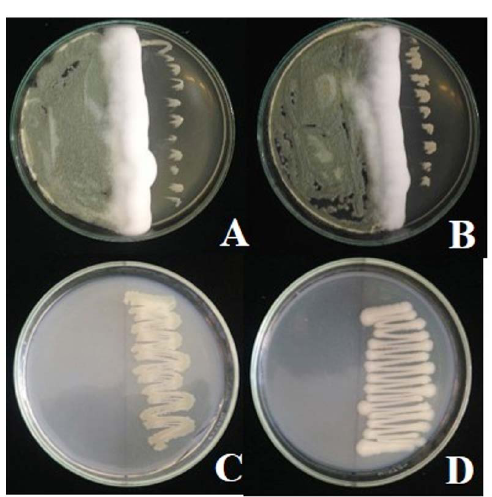
Fig. 5. Compatibility test of antagonistic bacteria B. pumilus FDKF5 or Bacillus sp. IKM1 and Metarhizium bio-product